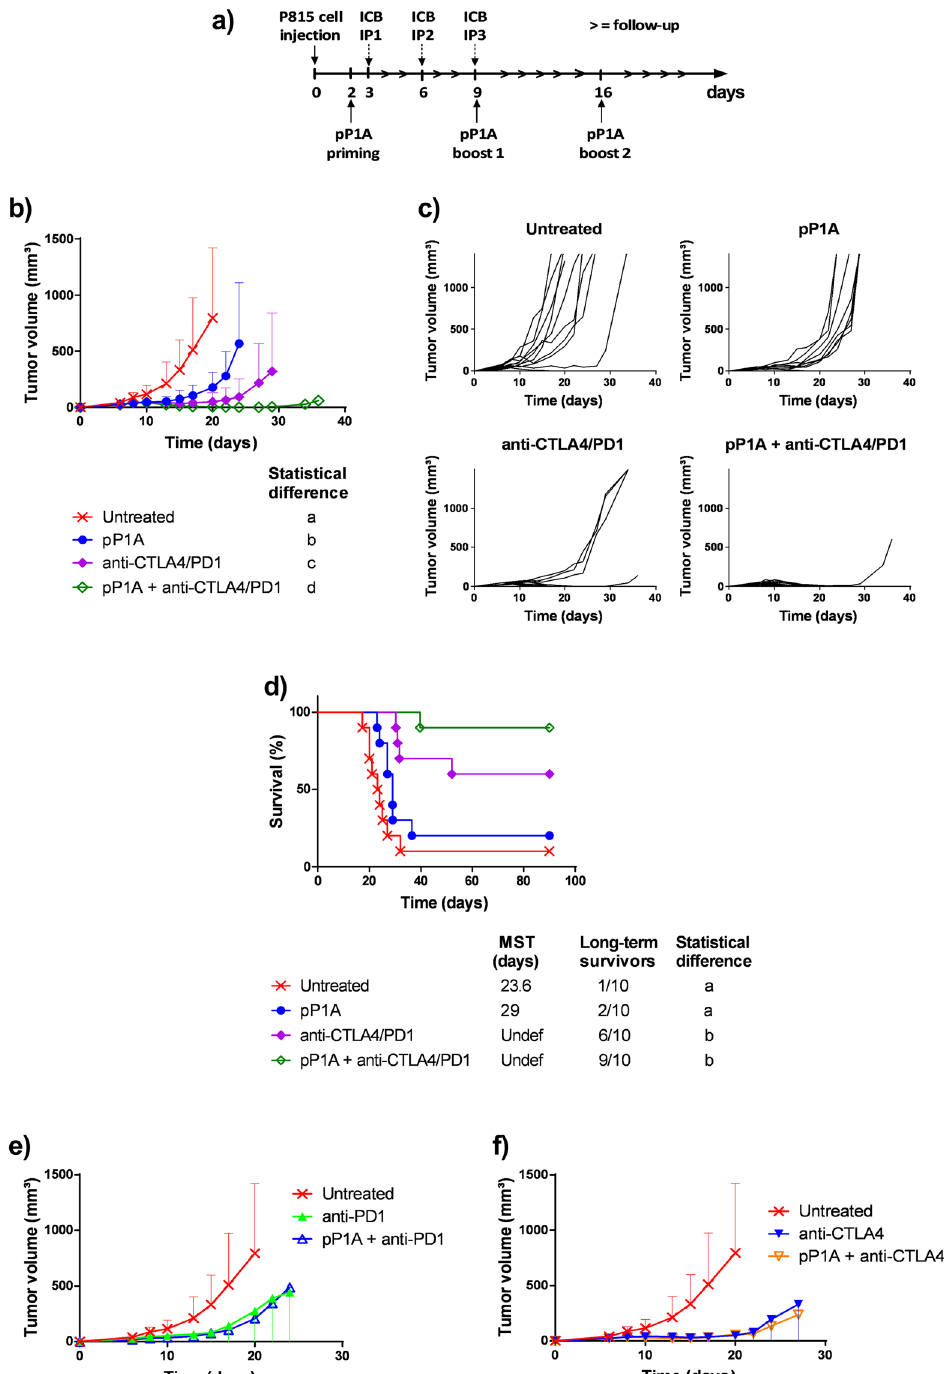
Figure 1. Therapeutic combination of pP1A and ICBs (anti-CTLA4/PD1). ( a ) Therapeutic vaccination protocol. ICBs were administered intraperitoneally (IP) 3 times every 3 days starting at day 3. The pP1A vaccine was administered 3 times weekly starting at day 2 by intramuscular electroporation. ( b ) Evolution of tumor volume (mm 3 ) after P815 challenge as a function of time (days) (mean ± SD). All the groups were statistically compared to the others using two-way ANOVA, column factor (p < 0.05, n = 10). ( c ) Tumor growth in individual mice and for every group of mice (n = 10). ( d ) Survival curve representing the percentage of living mice (%) as a function of time (days). Statistical analysis using log-rank (Mantel-Cox) test (significant difference when p < 0.05, n = 10). MST = median survival time. ( e , f ) Measurement of tumor volume (mm 3 ) after P815 challenge as a function of time for the anti-PD1 and pP1A + anti-PD1 groups ( d ) or for the anti-CTLA4 and pP1A + anti-CTLA4 groups ( e ) (days) (mean ± SD, n = 10). The absence of common letters in the statistical analysis ( a – d ) indicates statistically different